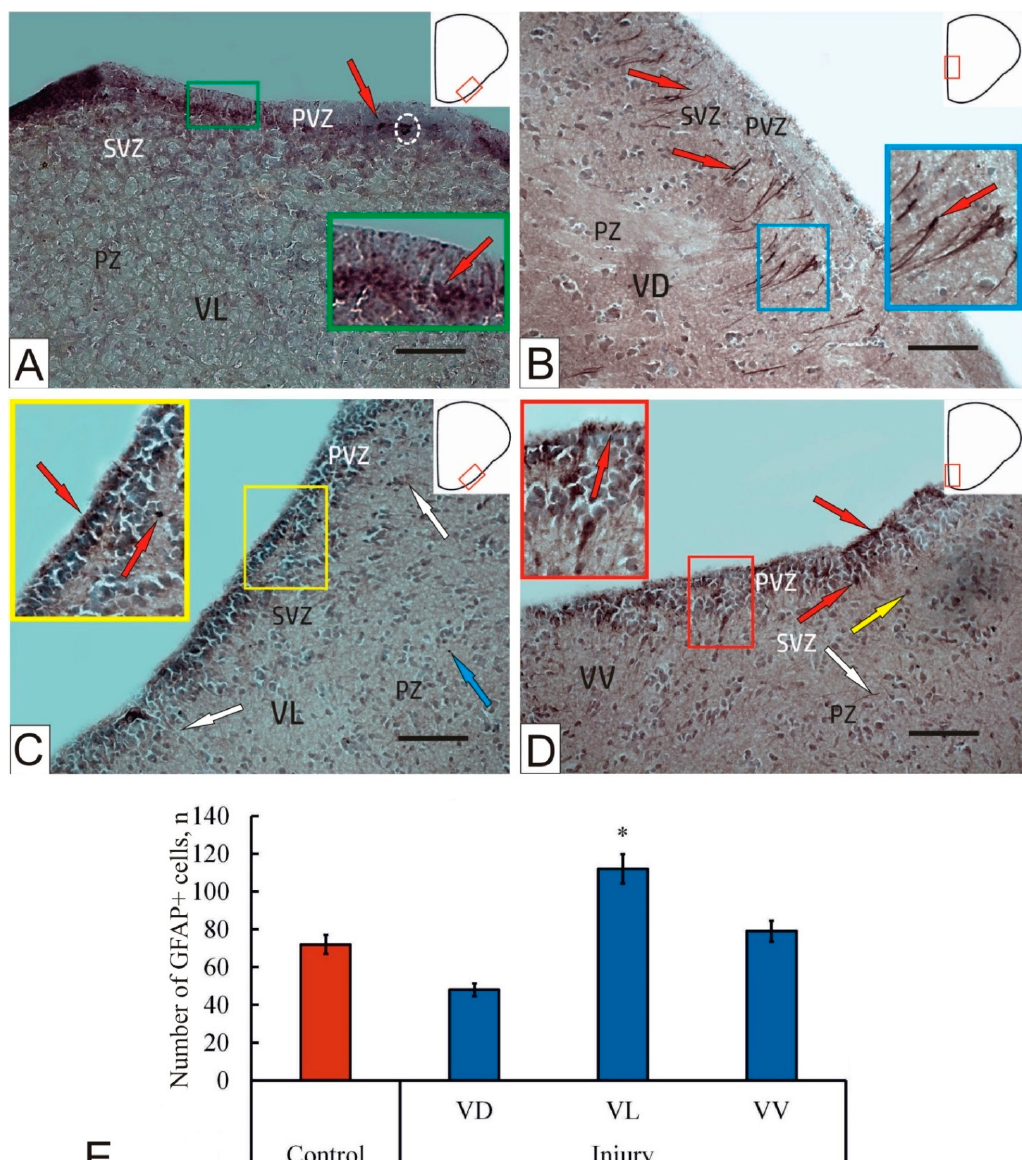
Figure 2. A representative image of GFAP-immunolabeling in the subpallial region of the intact telencephalon ( A ) of a juvenile Oncorhynchus masou and at 1 week after the traumatic injury ( B – D ) to the telencephalon: ( A ) localization of GFAP in intact lateral subpallium (VL), immunopositive cells (red arrows) and their clusters (white dashed oval) in PVZ (inset in the green rectangle); ( B ) GFAP+ cells conglomerates (red arrow) and clusters (inset in blue rectangle) in SVZ of VD at 1 week post-injury; ( C ) post-traumatic reorganization of GFAP immunopositivity in VL, GFAP+ heterogeneous complexes in PVZ and SVZ (an enlarged fragment is shown in the inset), alternating with immunonegative regions, radial glia fibers (white arrow), and GFAP+ granules (blue arrows); ( D ) heterogeneous GFAP+ cells after injury in the PVZ of VV (inset) and moderately labeled (yellow arrows), intensely labeled (red arrows), and radial glia (white arrows); ( E ) quantitative ratio of GFAP+ cells in intact animals (control group) and at 1 week post-injury ( n = 5 in each group, * p ≤ 0.05; significant difference vs. control). Student–Newman–Keuls test. Immunohistochemical labeling of glial fibrillar acidic protein in combination with methyl green staining. Scale bar: 100 µ